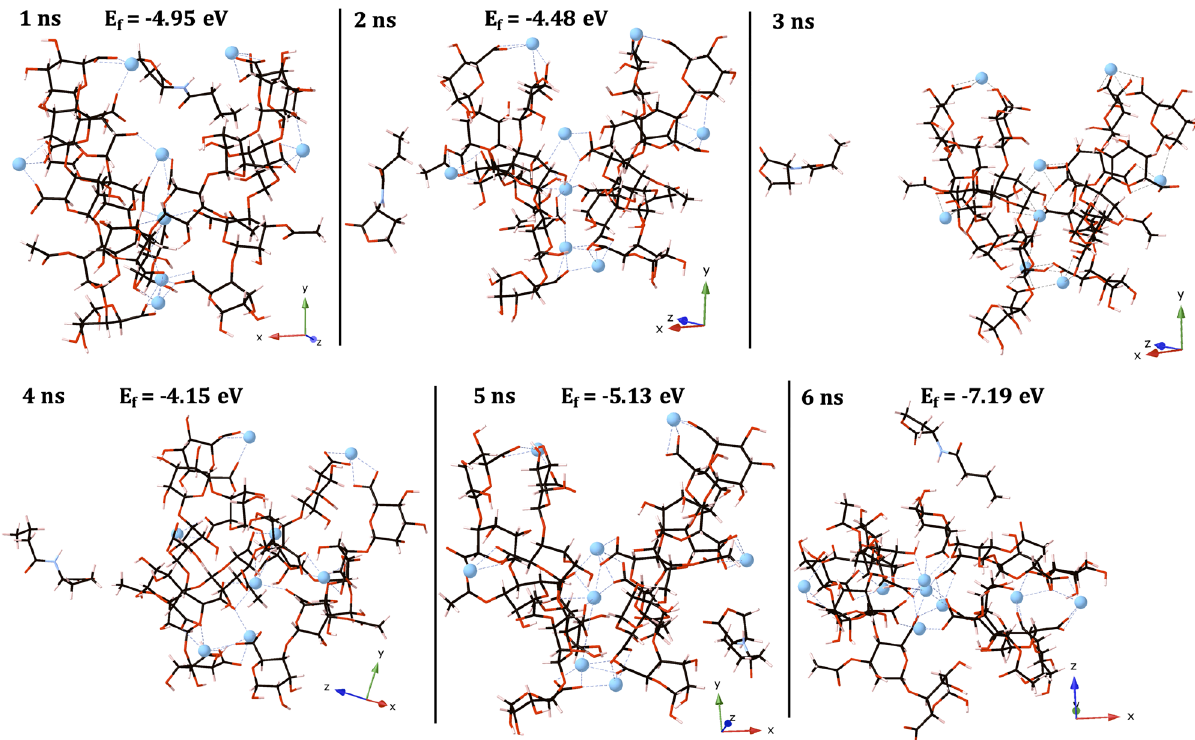
Figure 4. EPS-C 4 -HSL structures and their formation energies (eV). Carbon atoms are shown in grey, oxygen in red, calcium in blue and hydrogen in pink. Calcium–oxygen ionic bonds are shown with dashed blue lines. Formation energies weren’t calculated if the molecule > 6 Å away from the